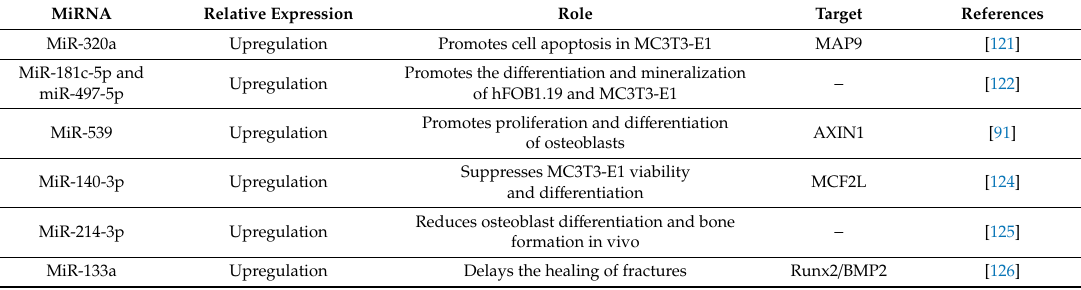
Table 10. Role of miRNAs in osteoporosis